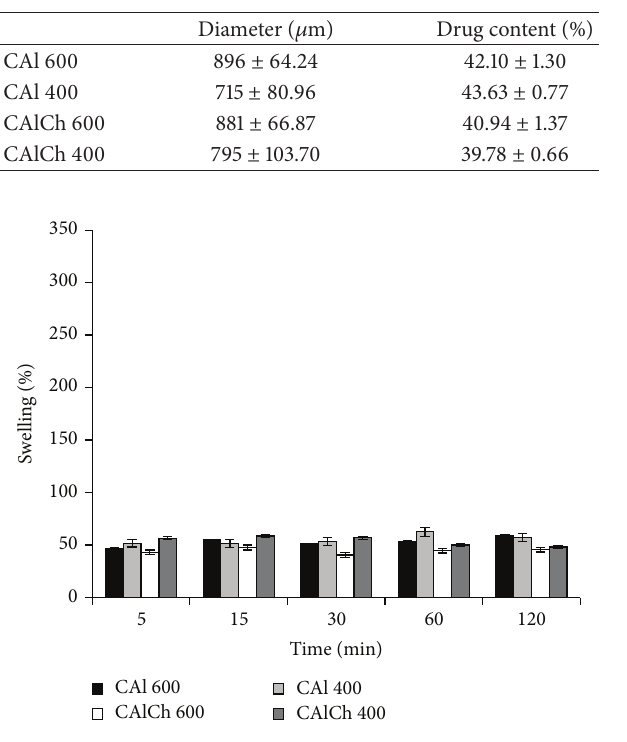
Figure 3: Swelling degree in hydrochloric acid at pH 1.0.